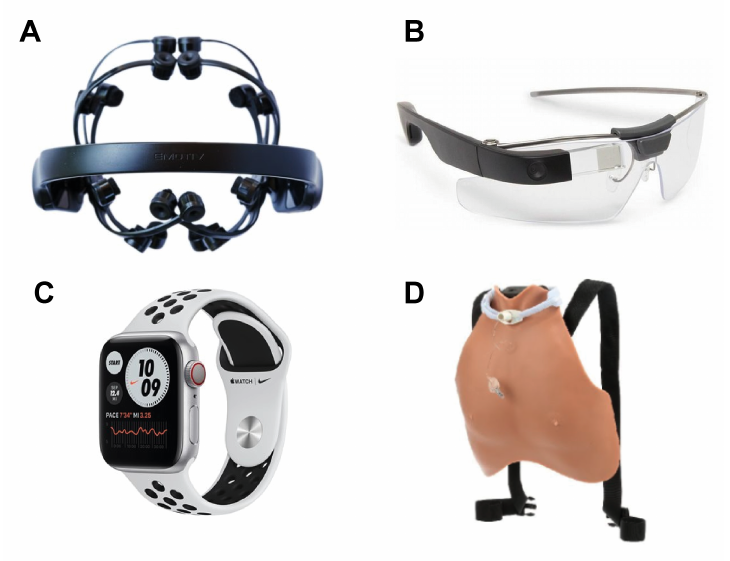
Figure 5. Various head-worn wearable have been used for educational purpose including ( A ) Emotiv EPOC EEG system [69] ( B ) Google Glasses in [71] and ( C ) Wearable wrist-worn like Apple Watch used in [82] and ( D ) Wearable chest-worn studied in